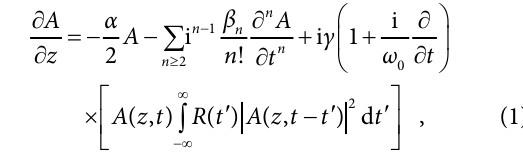
ize the effective broadening of the supercontinuum spec- trum toward longer wavelength 15 , but the flatness of the spectrum is poor. While pumping in the normal disper- sion region of the fiber, the flatness and coherence of the Short pulse Nonlinear fiber Supercontinuum Amplify Pump